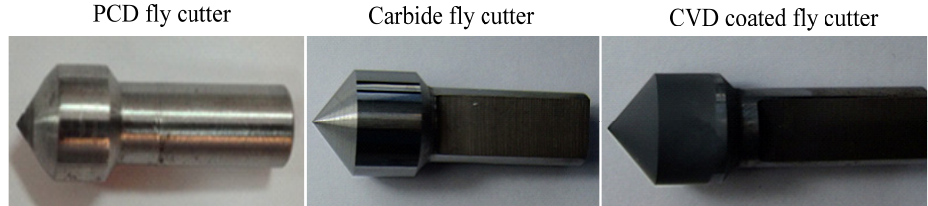
Figure 1. Carbon prepreg materials.